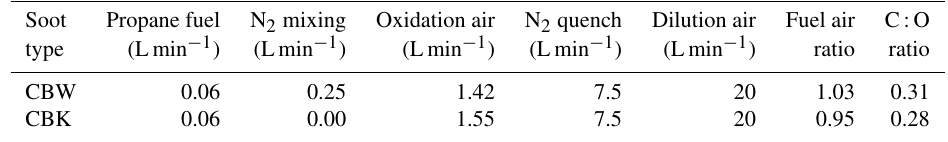
Table A1. miniCAST 4200 burner set points used to generate soot